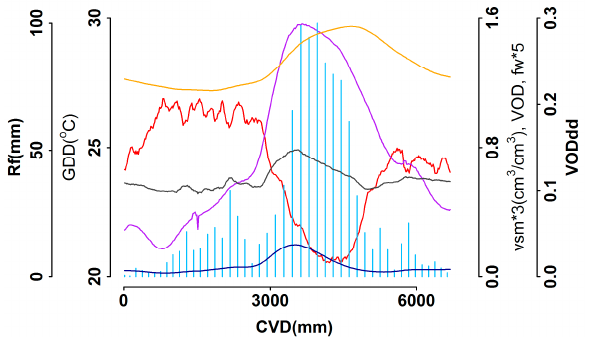
Figure 7. Average GDD, vsm, and (VODdd) VOD diel difference (#93, Ethiopia) time series graphs for 2003–2015. Purple indicates VODdd, while the legend for other variables is the same as that in Figure 5.